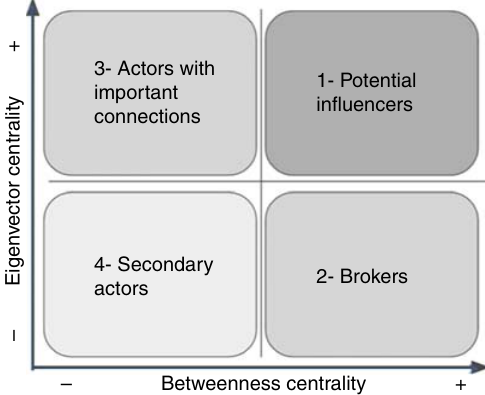
Figure 2. Matrix to detect potential influencers within a social network based on the work of Scoponi et al.